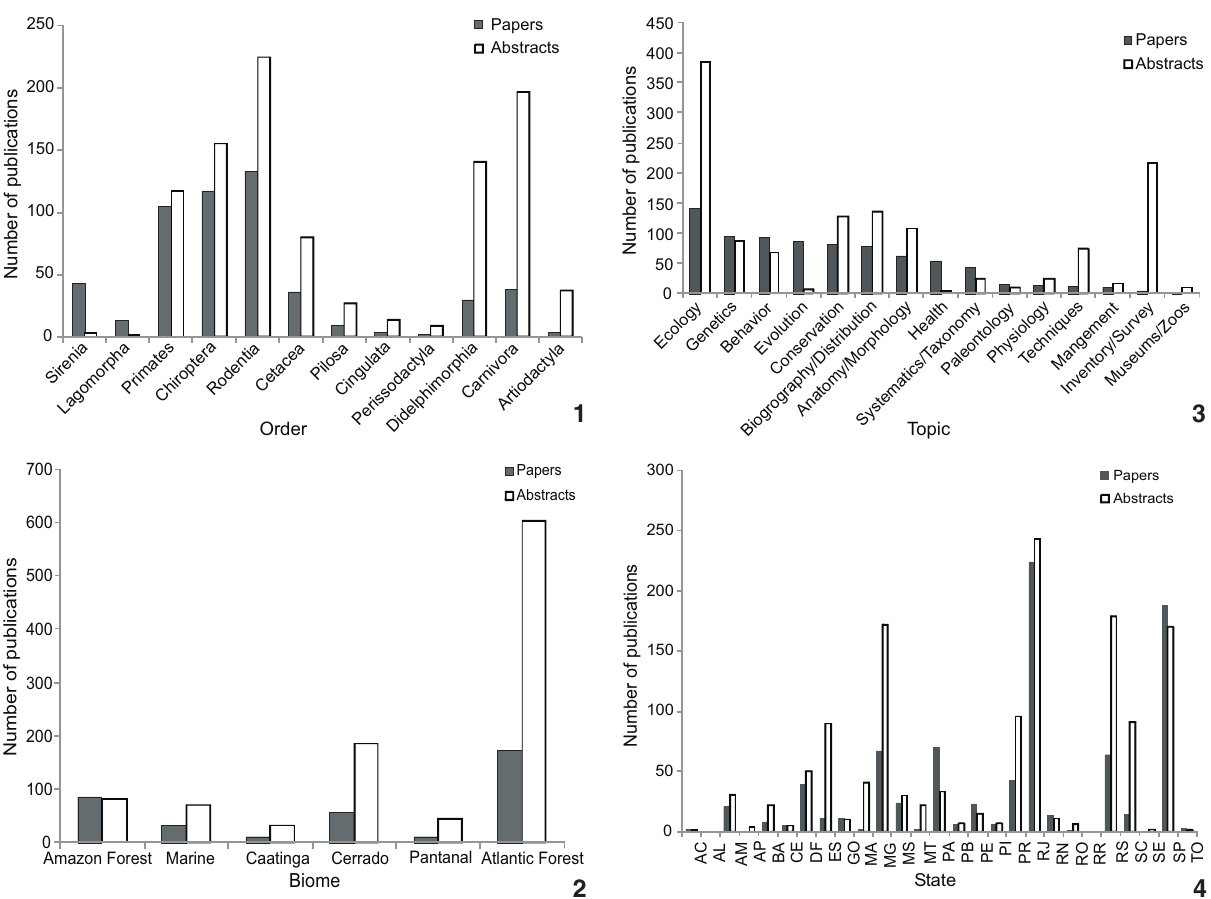
Figures 1-4. Distribution of publications (papers and abstracts) according to (1) mammalian order, (2) biome, (3) research topic and (4) state in Brazil between 2000 and